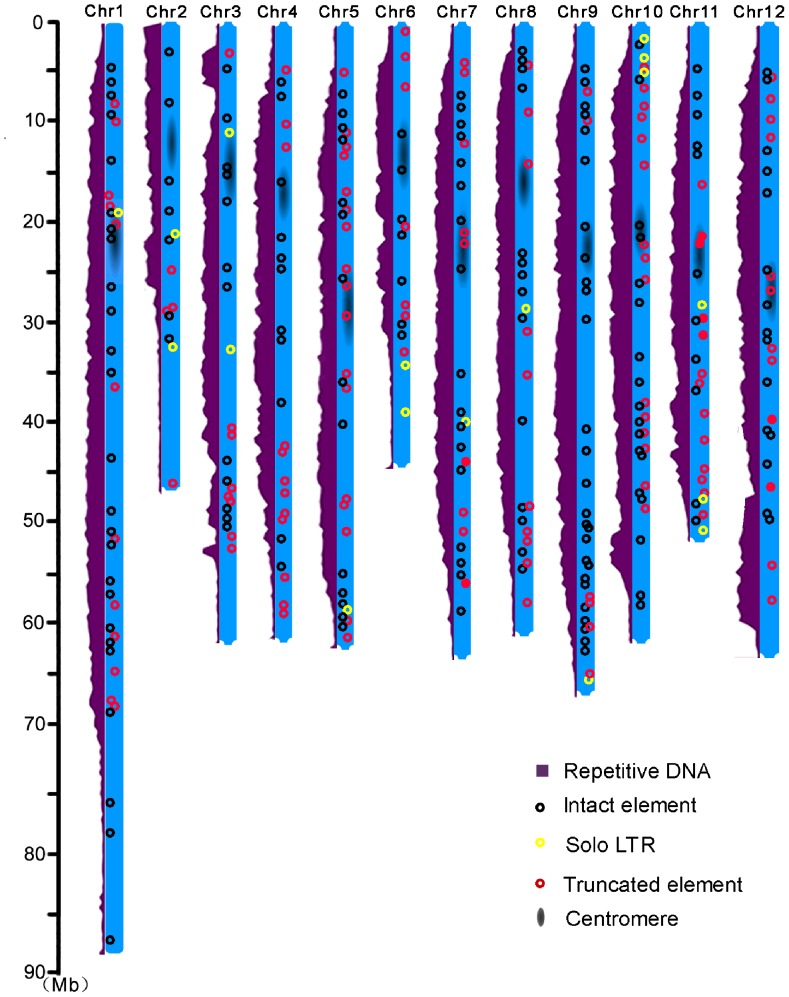
The distribution of TARE1 elements along 12 tomato chromosomes.Each chromosome is represented by a vertical blue box. The insertions and the total repetitive DNA are marked by circles and purple regions, respectively. The potential centromeric regions are indicated by a black blur in the middle [16].